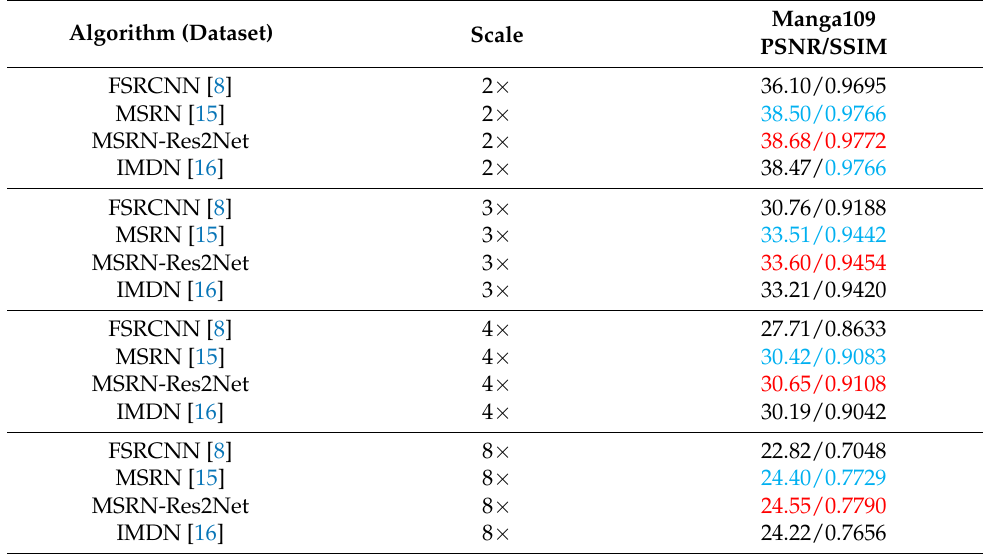
Table 2. Comparison of MSRN-Res2Net with MSRN, IMDN, and FSRCNN. The numbers in red and blue represent optimal and suboptimal values,